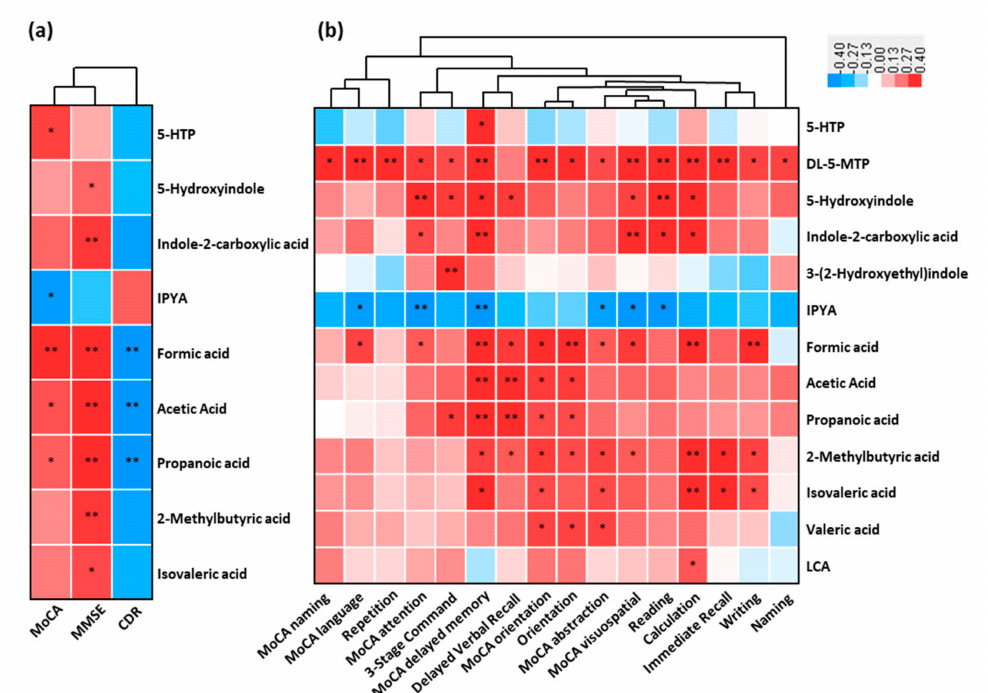
Figure 5. Linkage between altered metabolites of AD and cognitive impairment. Heat maps of Spearman rank correlation between the altered fecal metabolites including tryptophan metabolites, SCFAs, and bile acids, and ( a ) clinical parameters reflecting cognition function and disease severity, and ( b ) sub items in MoCA (naming, language, attention, delayed memory, orientation, abstraction and visuospatial) and MMSE sub domains (repetition, 3-stage command, delayed verbal recall, orientation, reading, calculation, immediate recall, writing and naming). Note: * p < 0.05; ** p < 0.01. Red means positive correlation and blue means negative. Abbreviations: MoCA, Montreal Cognitive Assessment; MMSE, Mini-Mental State Examination; CDR, Clinical Dementia